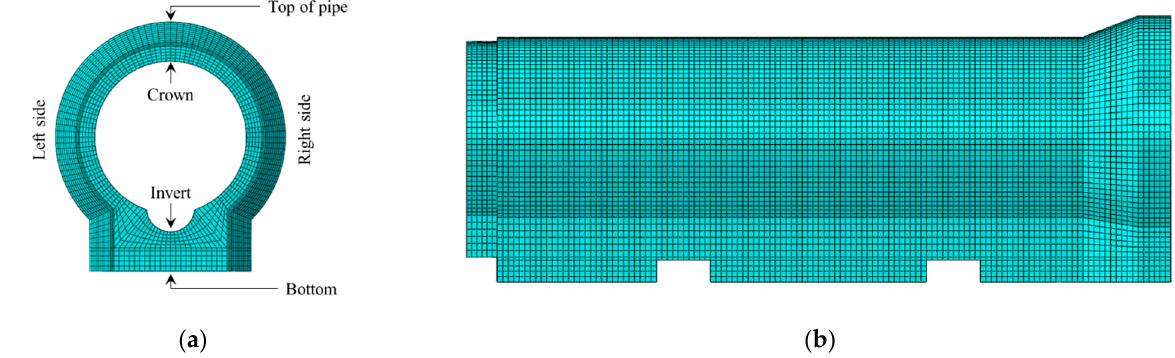
Figure 11. Design of the complex cross-section concrete pipe by 3D CFD mesh generation, ( a ) front view, ( b ) left side view.